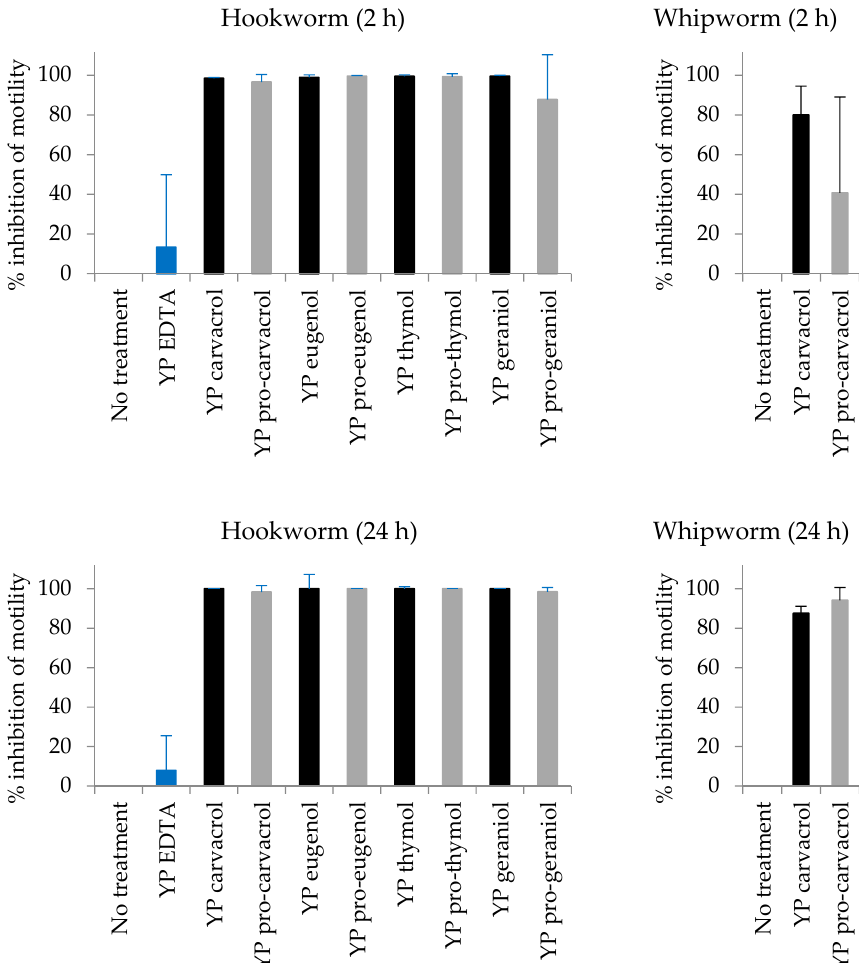
Figure 6. Inhibition of adult hookworm and whipworm motility by YP terpenes and YP pro-terpenes after 2 and 24 h incubation (results are average of eight worms per treatment). Percent inhibition of motility was calculated relative to the mean motility units of control worms (no treatment).